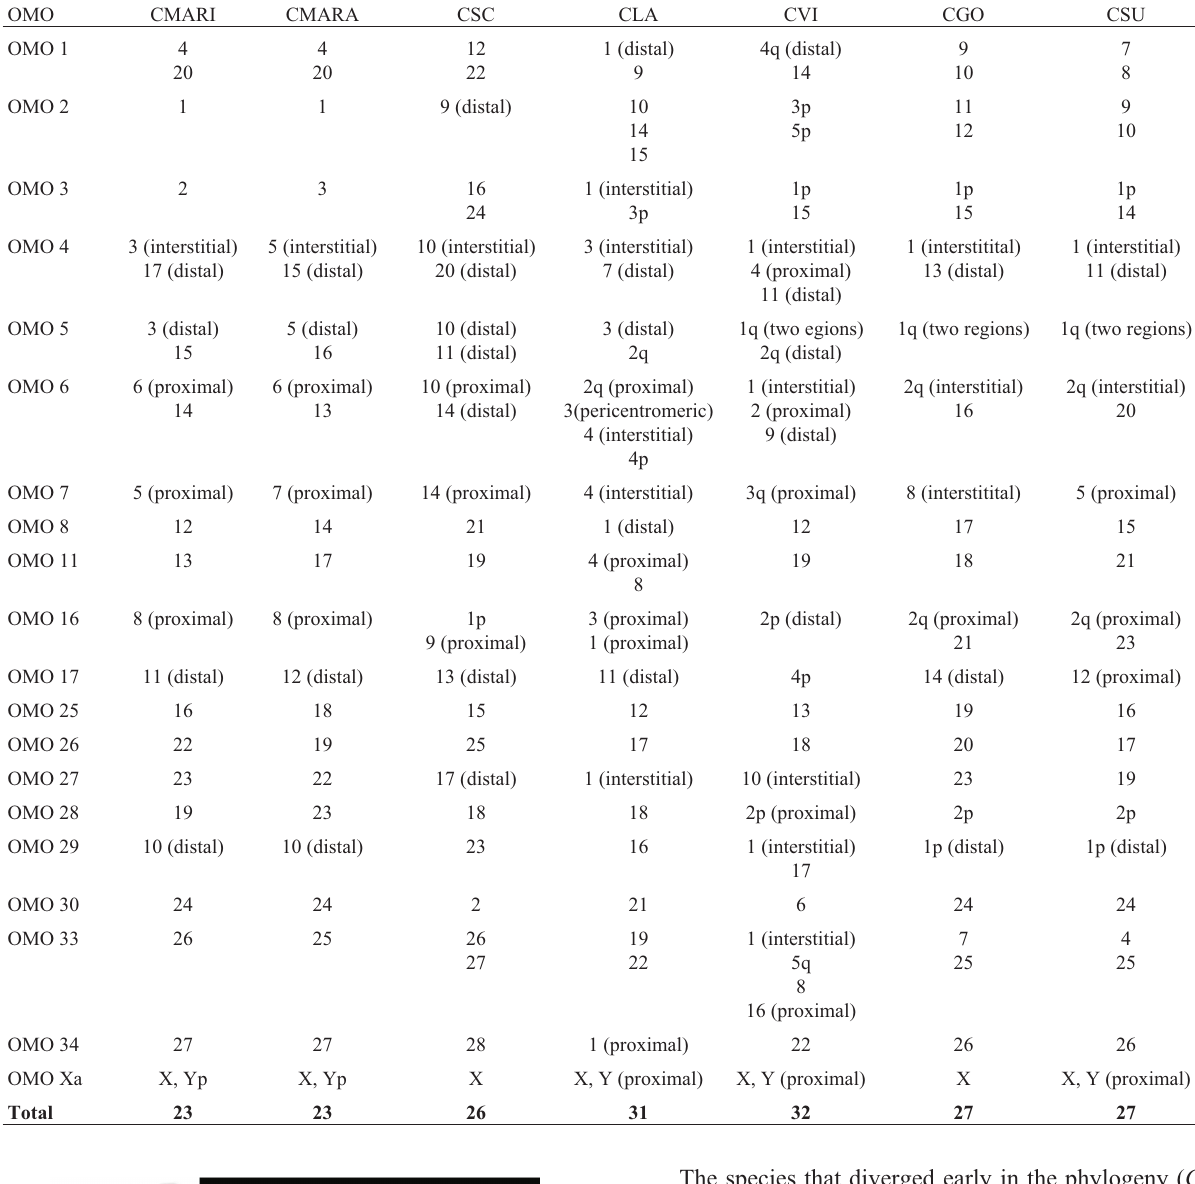
Table 2 - Homologous segments detected by chromosome painting with Oligoryzomys moojeni (OMO) probes in metaphases of seven Cerradomys spe- cies: C. marinhus (CMARI), C. maracajuensis (CMARA), C. scotti (CSC), C. langguthi (CLA), C. vivoi (CVI), C. goytaca (CGO) and C. subflavus (CSU).